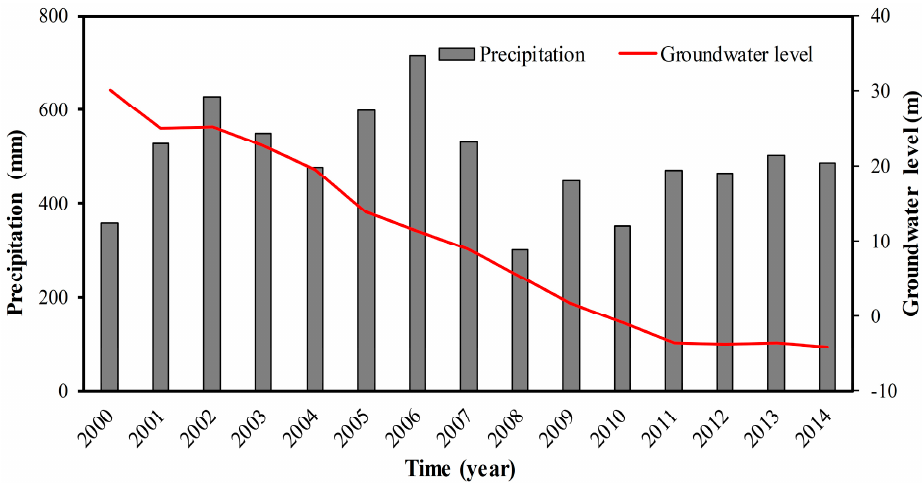
Figure 6. Changes in precipitation and mean groundwater levels in district 3.